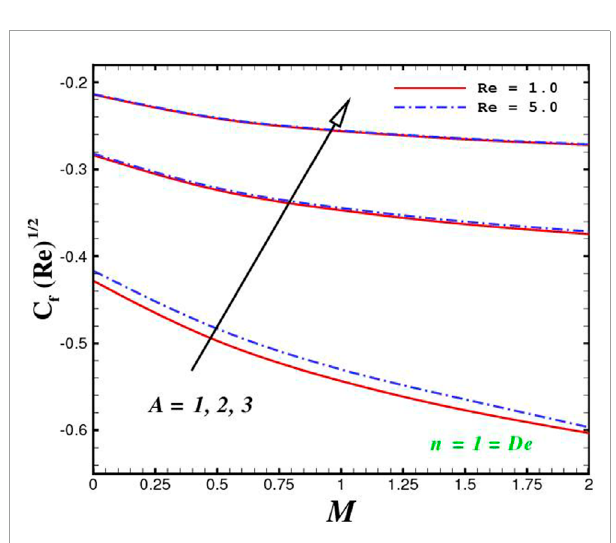
FIGURE 15 skinC f √ Re x , sketch for frequent values of A and M.